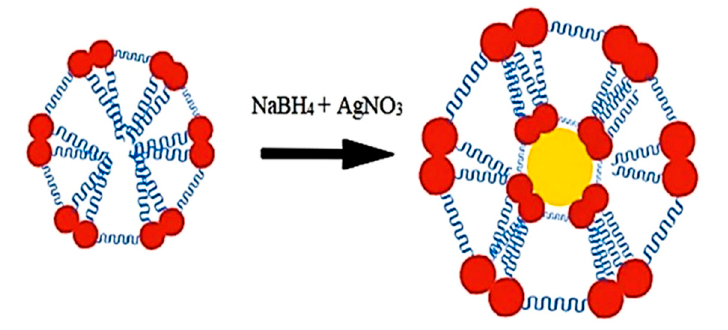
Figure 4. Schematic representation of the formation of layer of gemini surfactants, surrounding the Ag nanoparticles. Table 2. Experimental data of different procedures for AgNPs obtaining.